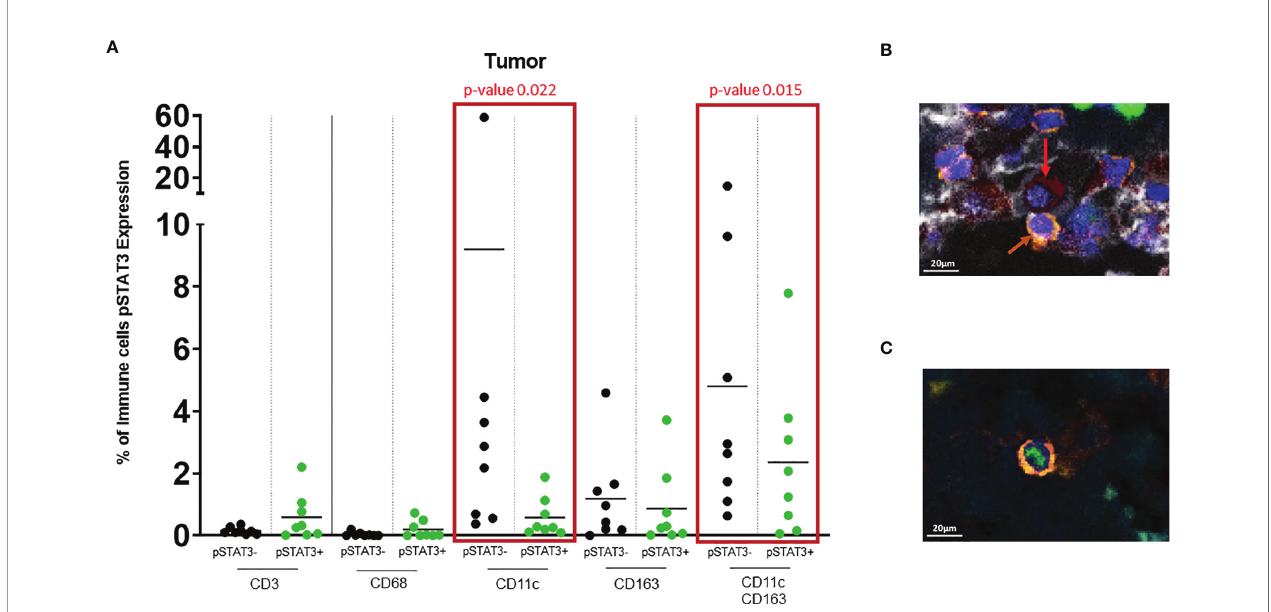
FIGURE 3 | (A) Dot plot showing % of pSTAT3- vs pSTAT3+ cells in the tumor area. Green circles represent pSTAT3+ populations and black circles represent pSTAT3- populations. Each circle represents a specimen. Red-outlined rectangles highlight the signi fi cative comparisons with p-values ≤ 0.05. CD11c+pSTAT3- cells and dual CD11c+CD163+pSTAT3- cells are signi fi cantly higher relative to CD11c+pSTAT3+ cells (p=0.022) and CD11c+CD163+pSTAT3+ cells (p=0.015) respectively. The other immune cell populations do not show any signi fi cant difference. (B) In tumor stroma, pSTAT3- T cells (orange arrows) can be seen in tight proximity to CD11c+CD163+pSTAT3- cells (red arrows). (C) pSTAT3+ T cell isolated in